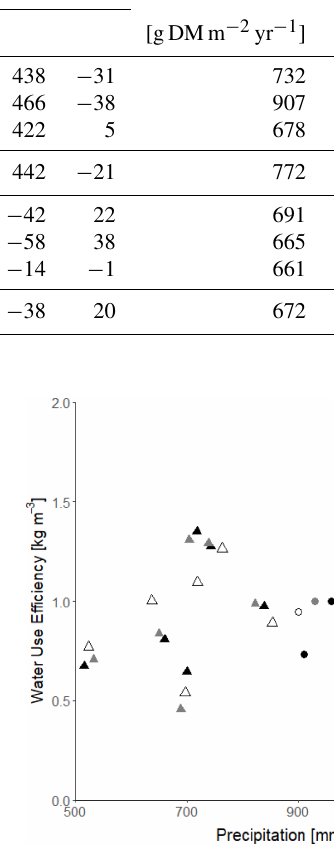
Figure 2. Water use efficiency (i.e. annual harvest divided by an- nual evapotranspiration) as a function of annual precipitation at Sel- hausen and